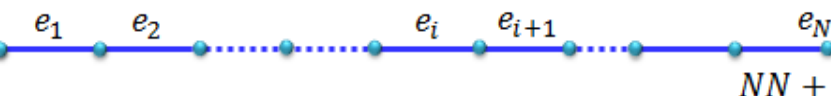
Figure 4. Geometrical view of physical domain and computational domain.